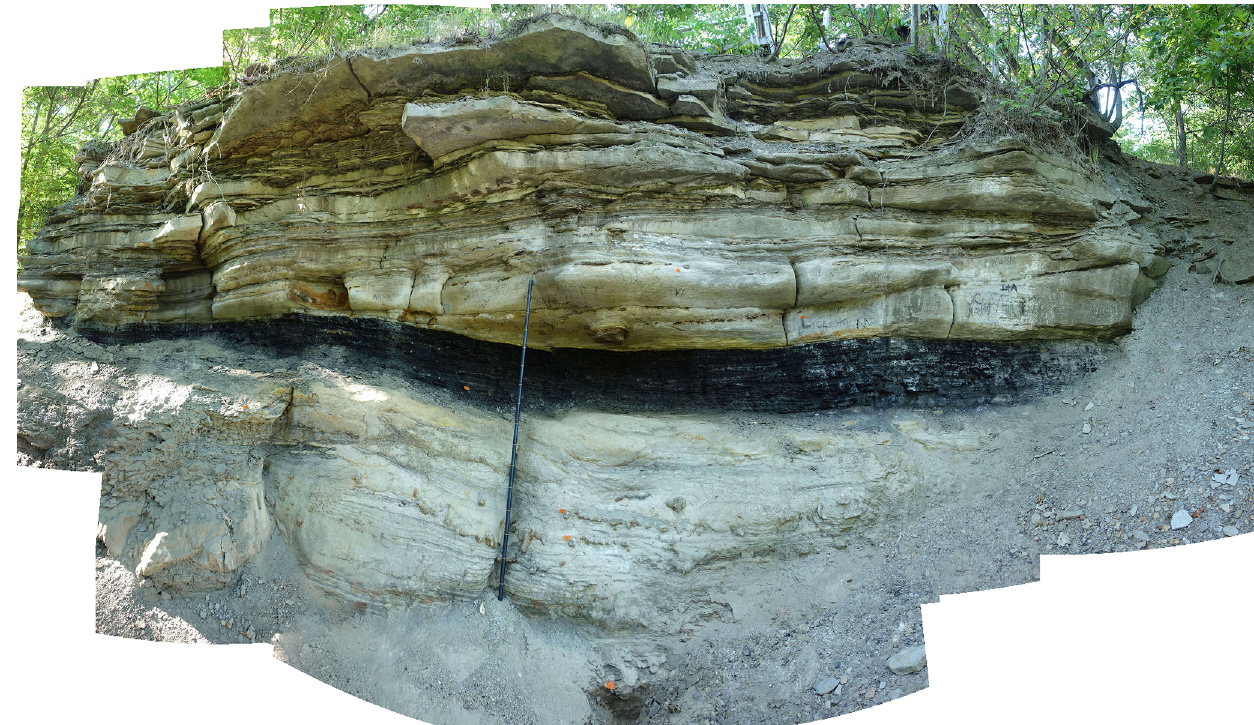
Figure 1. Stitched panorama photo of the American Vitrified 2 outcrop (staff is 1.6m and has 10cm increments). This image is used in Parts 2–5 of the assignment. Figure 2 is the equivalent 3D model of this outcrop, and the corresponding stratigraphic log is in Fig. 6.